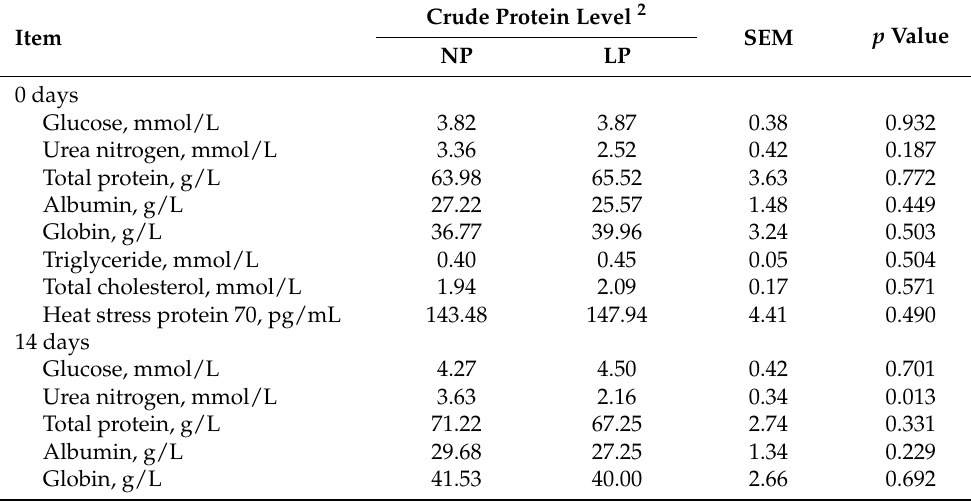
Table 5. Effects of dietary crude protein level on the serum biochemical parameters of finishing pigs 1 .